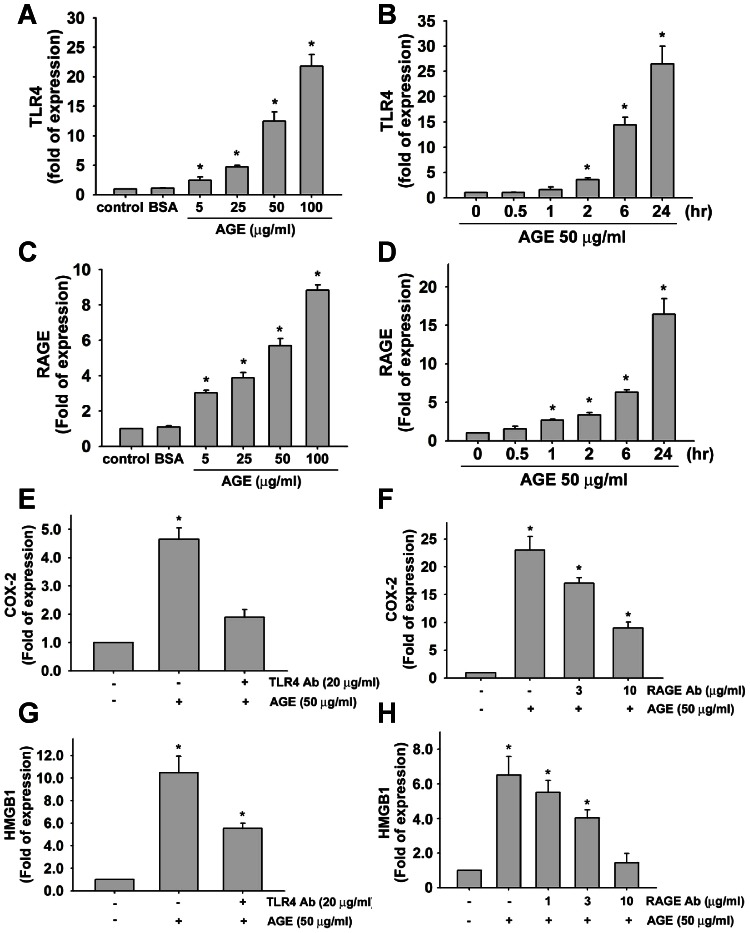
Densitometric analysis for TLR4, RAGE, COX-2, and HMGB1 levels.Values are corrected to α-tubulin or β-actin levels. All data are presented as mean ± SEM for three independent experiments. *: P<0.05 versus control. #: P<0.05 versus AGEs alone.